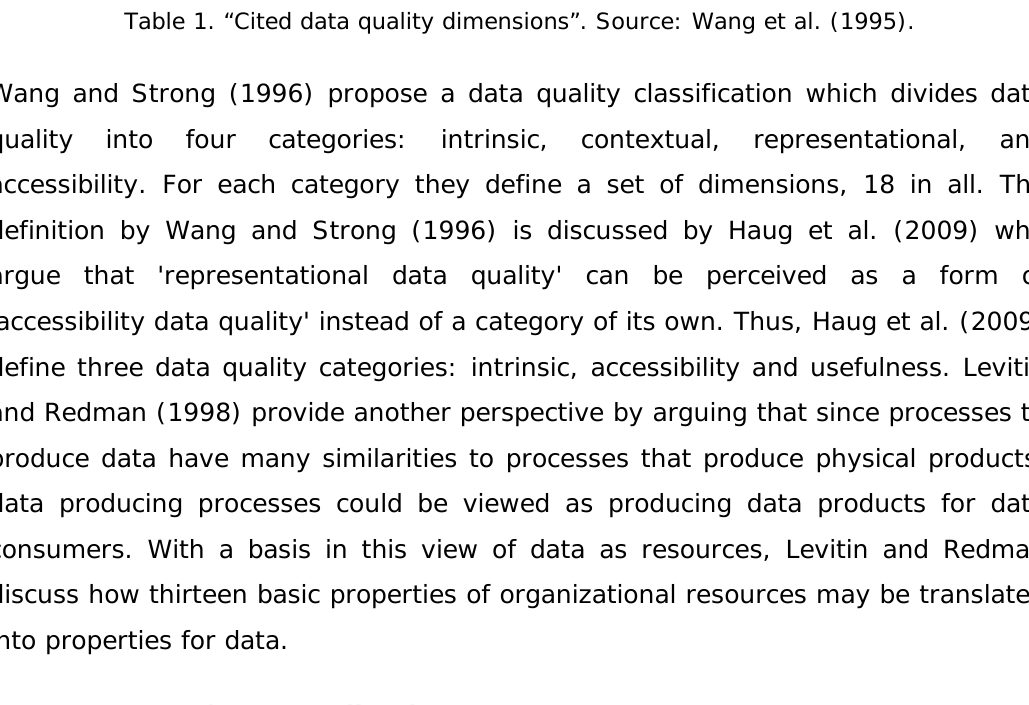
Table 1. “Cited data quality dimensions”. Source: Wang et al.